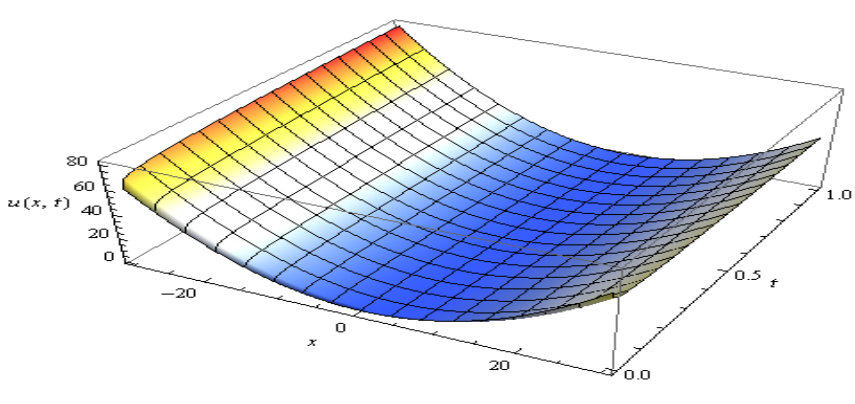
Figure 6. Sub-diffusion case of incompressible second grade fluid